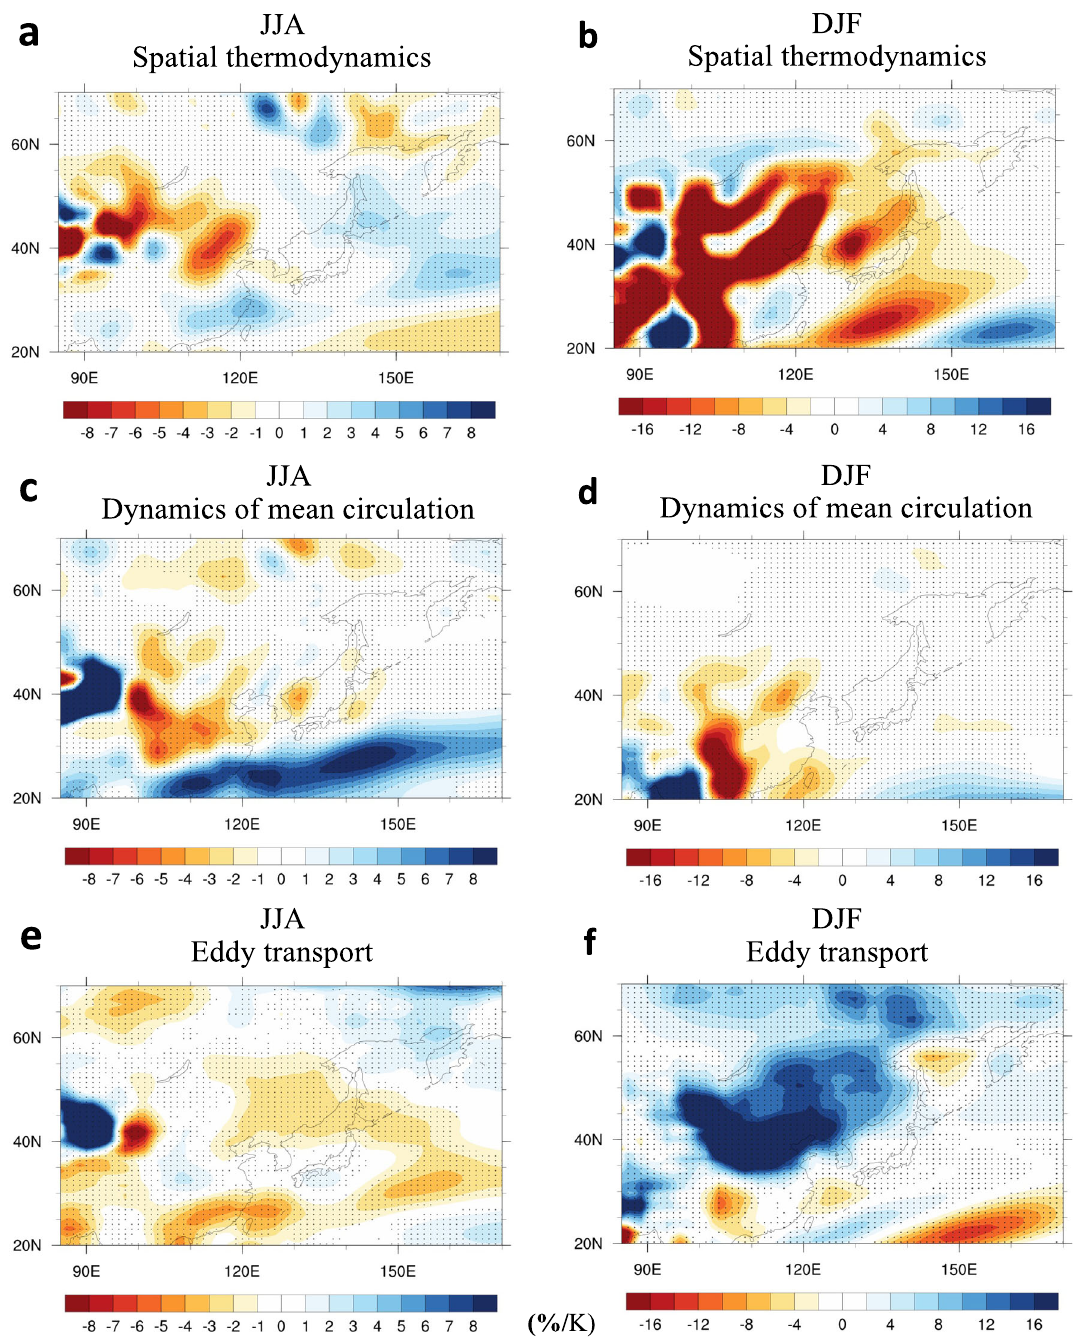
Fig. 2 Contribution of different processes to the scaling of total moisture convergence. a , c , e For JJA; b , d , f for DJF; unit is %/K. a , b Spatial thermodynamics. c , d Dynamics of the mean circulation. e , f Eddy moisture transport (unit: %/K). Stippling represents statistical signi fi cance at 5% level in student t